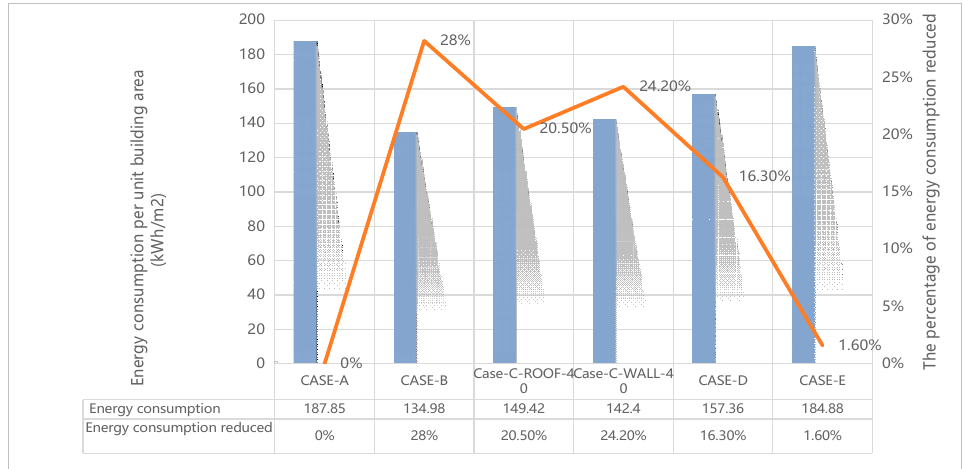
Figure 10. Energy-saving rates of different measures. CASE-A: a traditional tubular house built in the form of townhouses; CASE-B: solar energy use with sunroom; CASE-C-ROOF-40: insulation roof with 40 mm XPS; CASE-C-WALL-40: insulation wall with 40 mm XPS; CASE-D: sloping roof with air gap; CASE-E: double single-glazed windows.